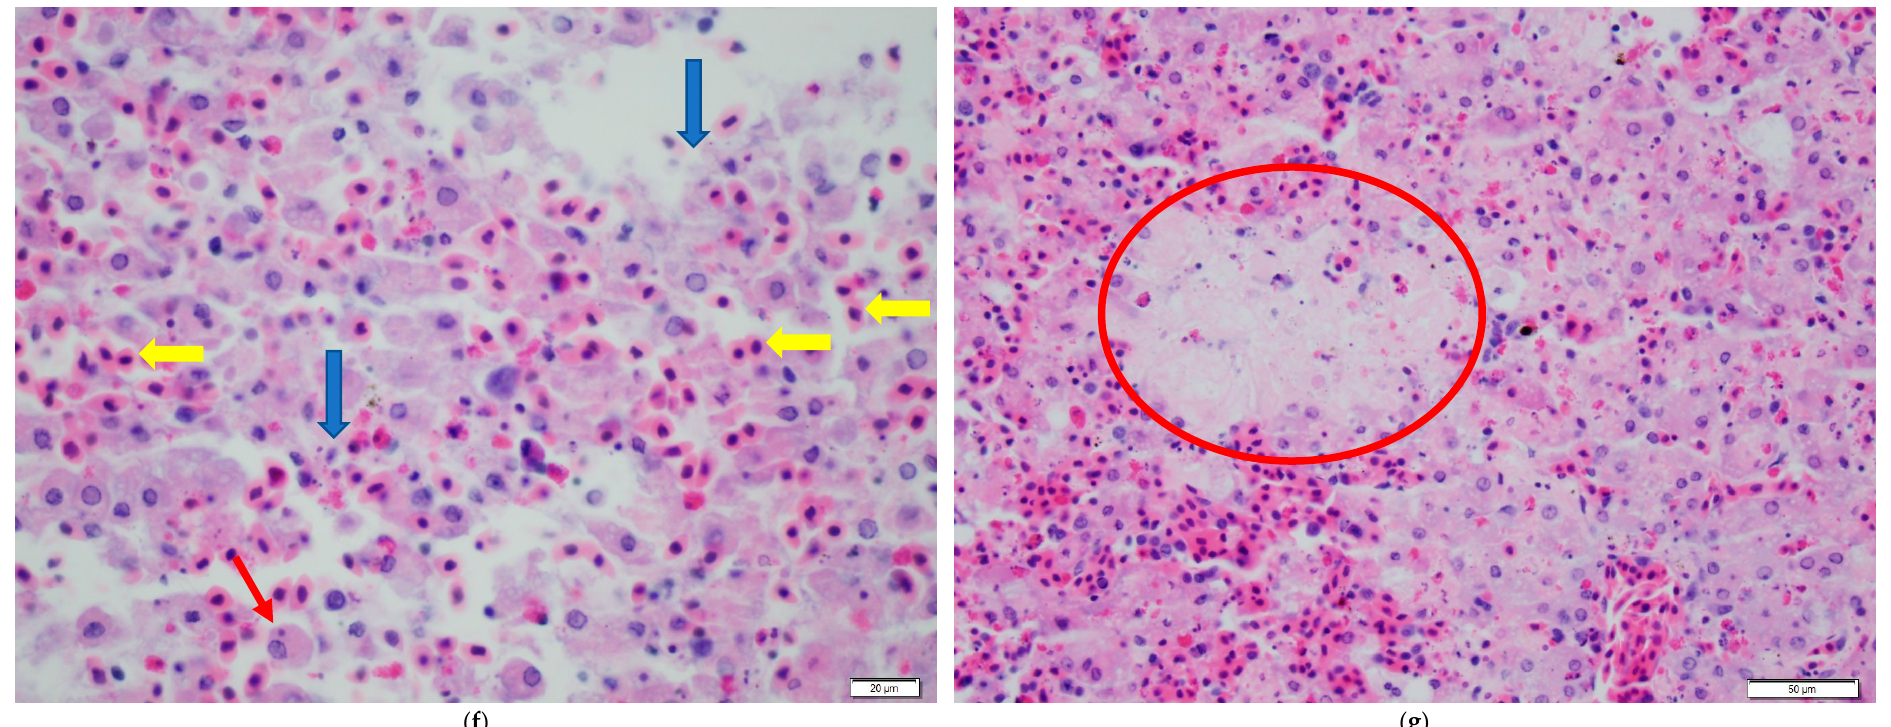
Figure 3. Representative tissues from hatching turtles ( Trachemys scripta elegans ) experimentally exposed to herbicides and ranavirus. Hematoxylin and eosin stain. Images are large and labels are on each for the purpose of manuscript review. ( a ) Turtle 40 (atrazine, ranavirus-exposed), liver showing areas of necrosis; ( b ) Turtle 48 (atrazine, ranavirus-exposed), liver showing necrosis of hematopoietic tissue and intracytoplasmic inclusions in granulocytes; ( c ) Turtle 62 (Rodeo, ranavirus-exposed), liver showing inclusion body consistent with ranavirus; ( d ) Turtle 66 (no herbicide, ranavirus-exposed), showing inclusions in hepatocytes (blue arrows) and hematopoietic necrosis (yellow arrows); ( e ) Turtle 76 (Roundup, ranavirus-exposed), showing hematopoietic necrosis in pancreas; ( f ) Turtle 94 (Rodeo, ranavirus-exposed), liver showing hematopoietic and hepatocellular necrosis (blue arrow), intracytoplasmic inclusion body (red arrow), and hemorrhage (yellow arrows); ( g ) Turtle 122 (no herbicide, ranavirus-exposed), liver showing hepatocellular necrosis.